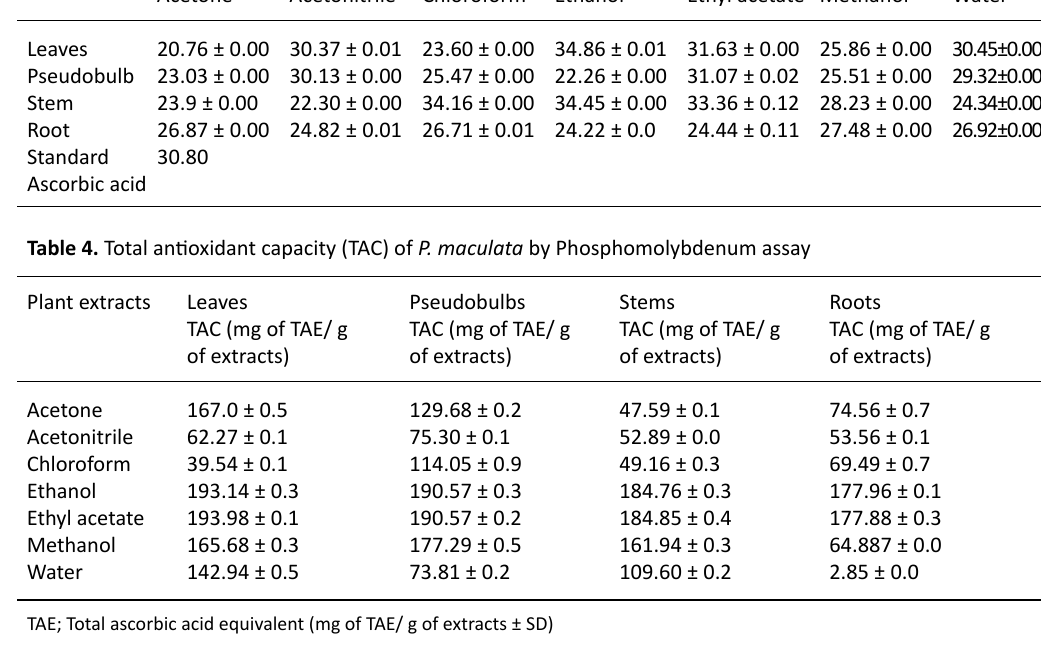
of DPPH radical scavenging activity of Pleione maculata extracts table 3. IC 50 Plant extracts